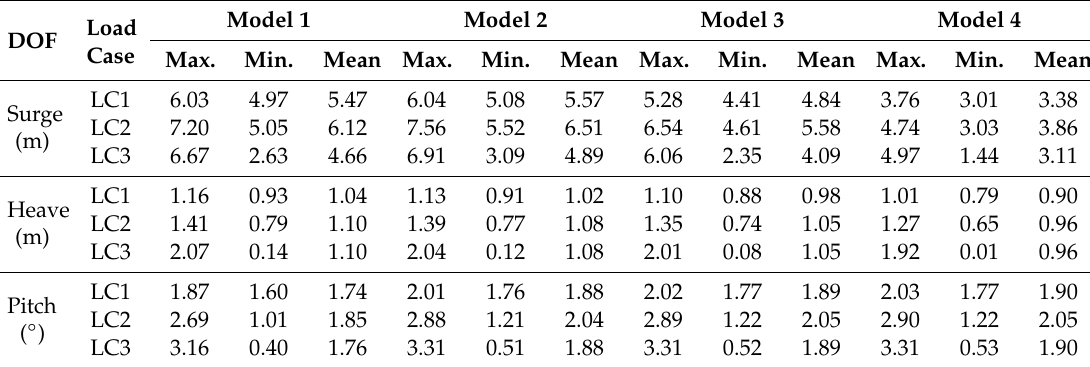
Figure 10. Time domain curves of the pitch motion of Model 1–4: ( a ) LC1; ( b ) LC2; and ( c ) LC3. Table 9. Statistics of the stationary motion of the multi-segmented mooring line models.